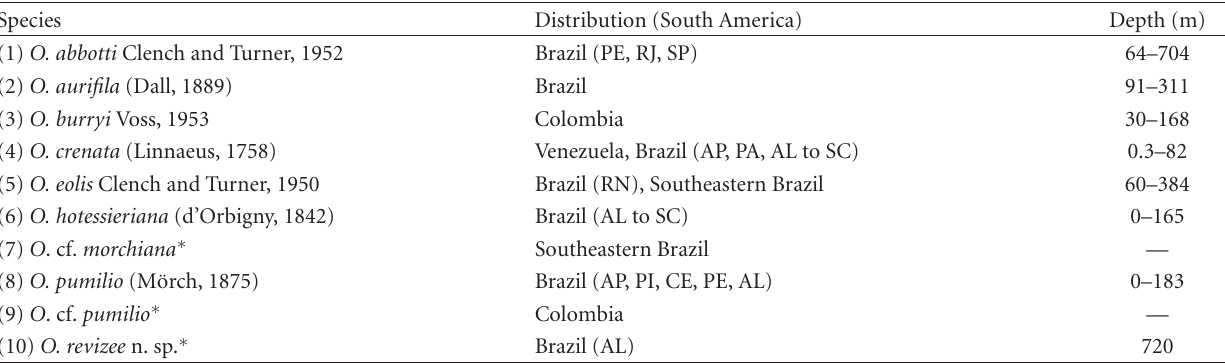
Table 2: Checklist of species of the genus Opalia known for the Atlantic coast of South America with geographic and bathymetric distribution.